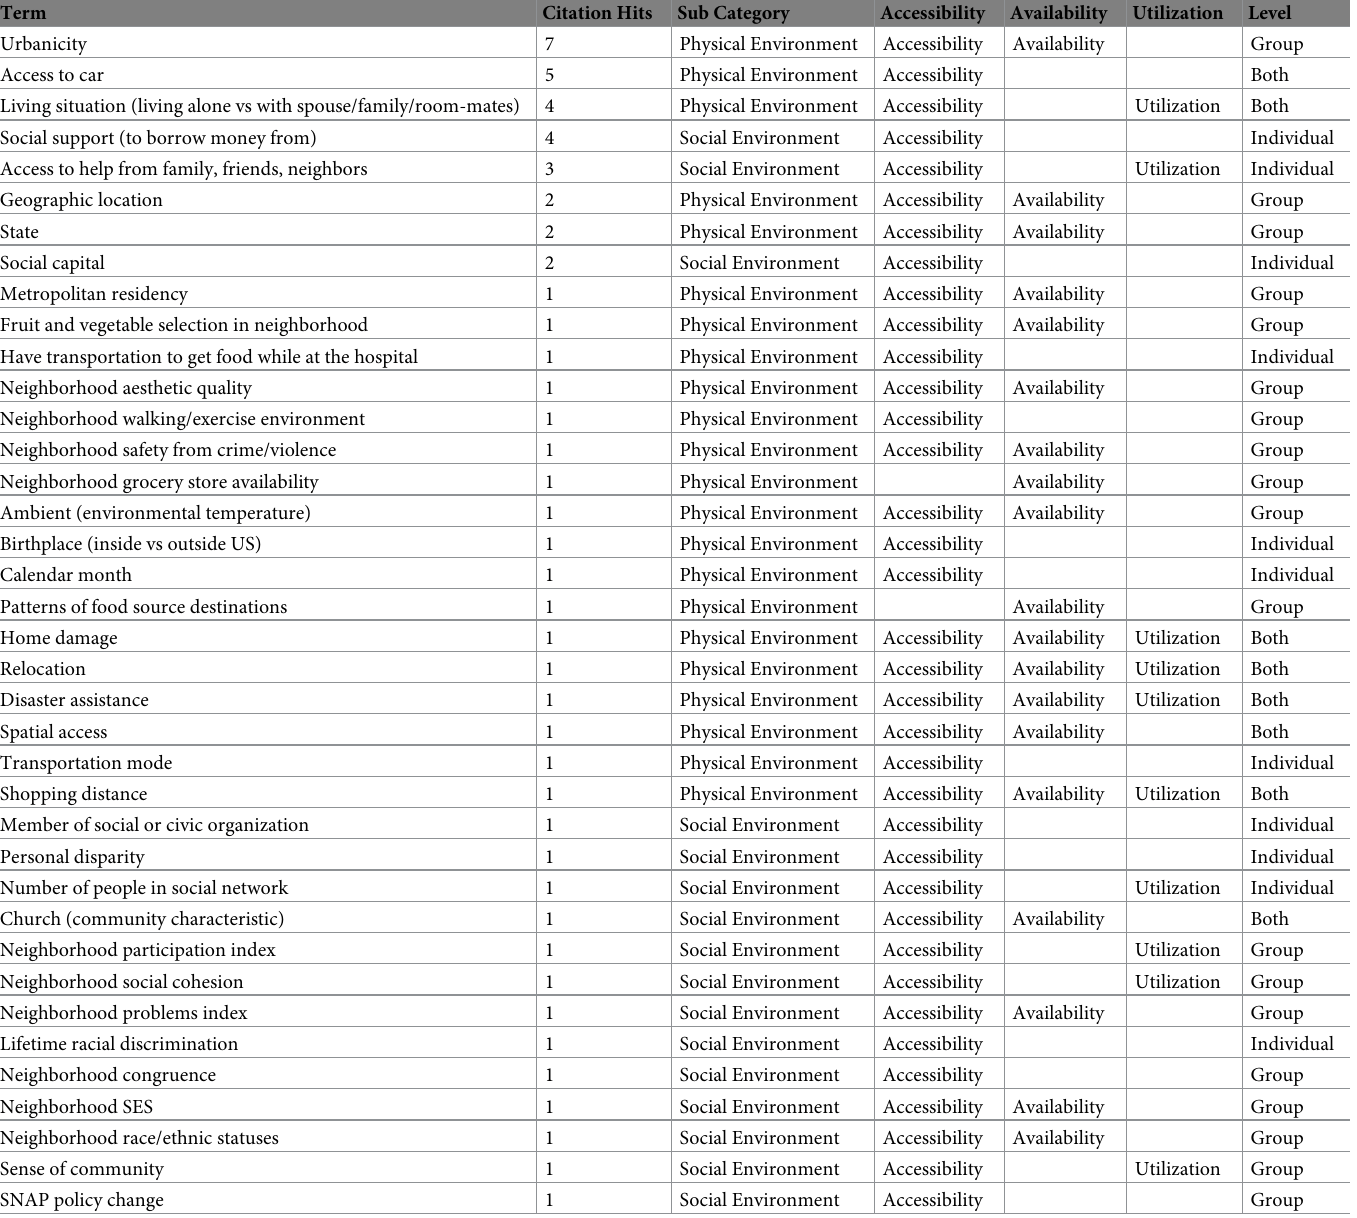
Table 4. Environmental risk factors mapped to the dimensions of food